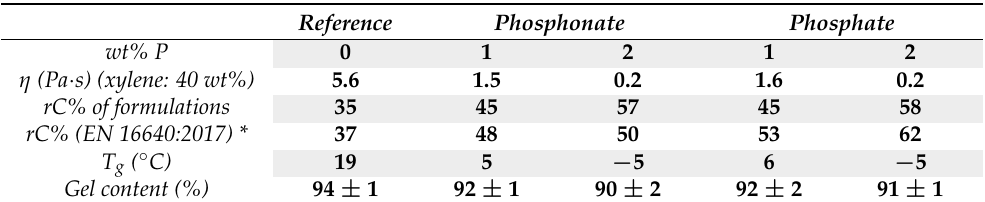
Table 2. Viscosity, T g and gel content of phosphorylated cardanol reactive diluent alkyd resins with a fixed NVC at 60 wt%. Reference Phosphonate Phosphate wt% P 0 1